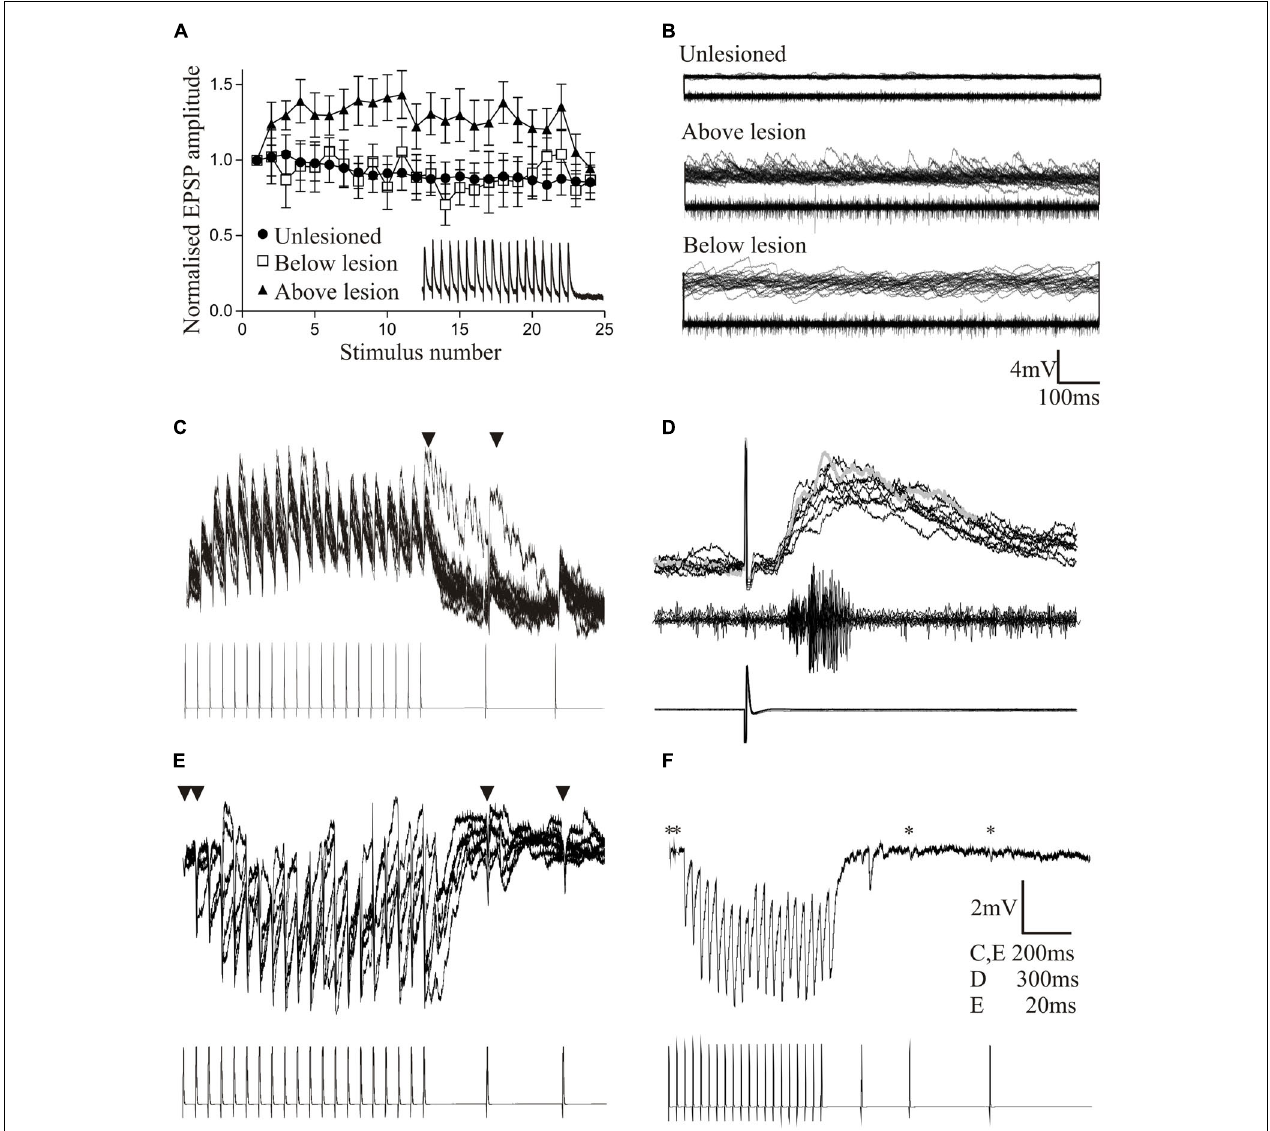
FIGURE 5 | Changes in reticulospinal-evoked synaptic inputs to motor neurons in unlesioned juvenile animals, and lesioned animals above and below the lesion site. (A) Note the facilitation above, but depression below the lesion site and in unlesioned animals. (B) Spontaneous synaptic inputs above and below the lesion site in juvenile adult animals. (C,D) Evidence for polysynaptic excitatory synaptic interactions (indicated by ∗ ) above the lesion site. (E,F) Polysynaptic inhibition below the lesion site in juvenile adult animals (in this case ∗ refers to inputs that failed to evoke an input, IPSPs only developing during the spike train as a result of activation of the feedforward inhibitory pathway). Data from Becker and Parker (2015). No permission is required to reproduce this